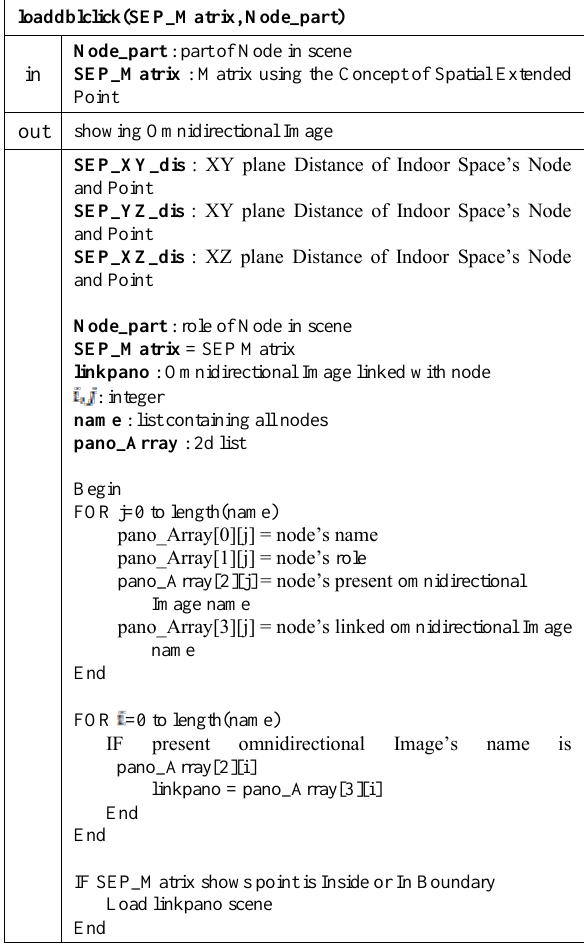
Figure 10. Pseudocode for navigation using SEP concept